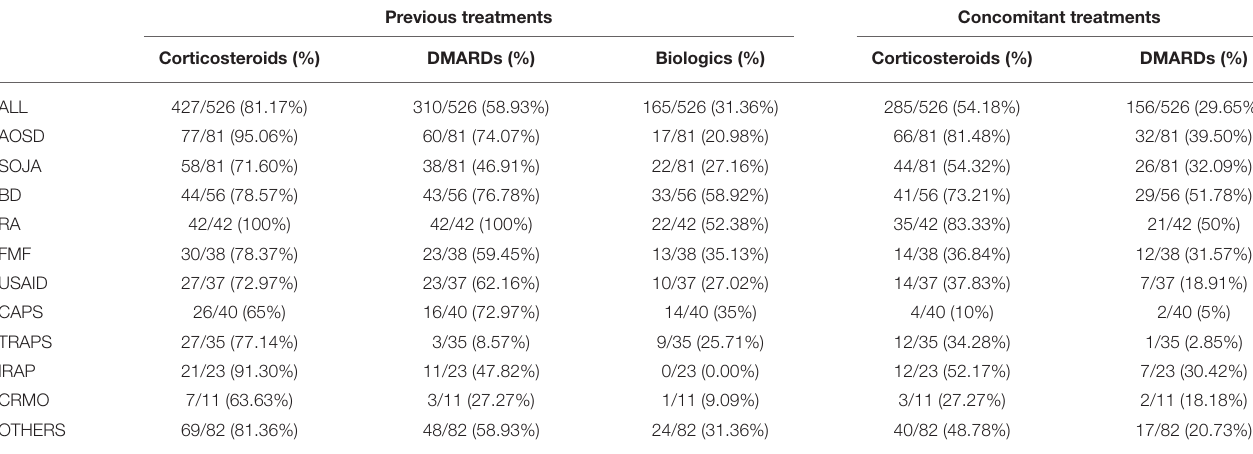
TABLE 2 | Previous and concomitant treatments administered to all patients.